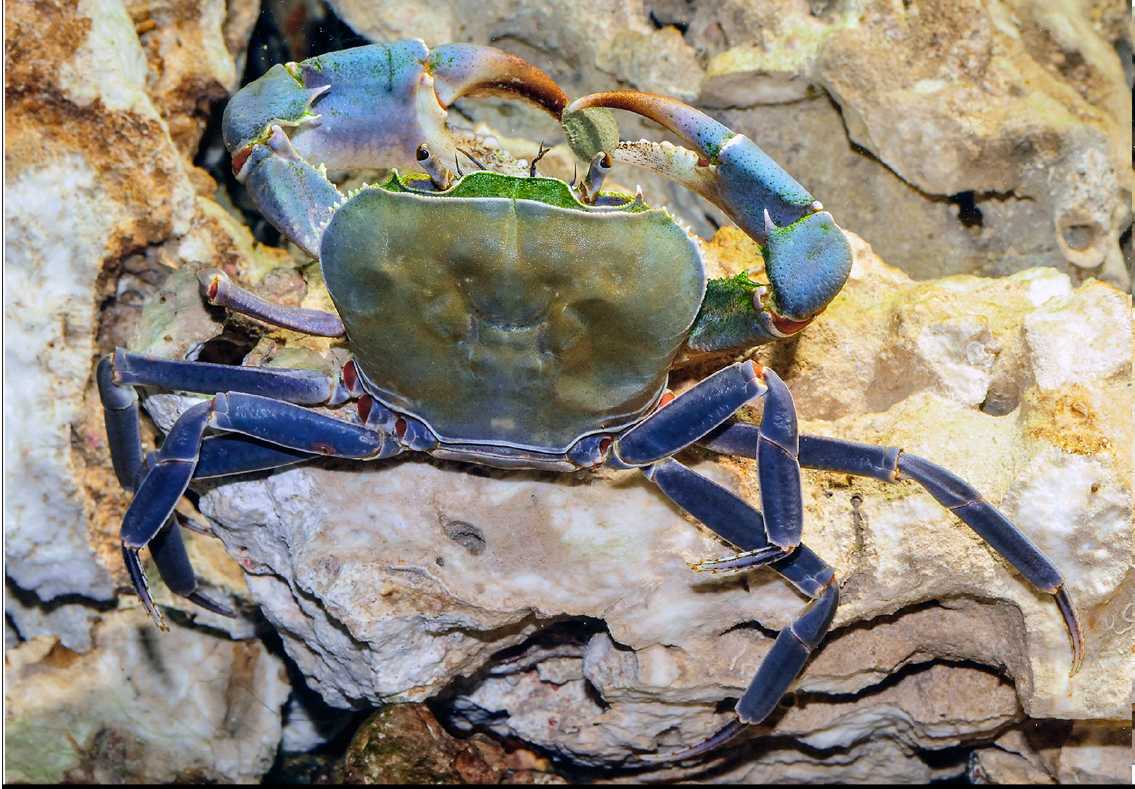
Fig. 13. Potamonautes orbitospinus (Cunnington, 1907), living specimen from Lake Malawi, Malawi. Photograph